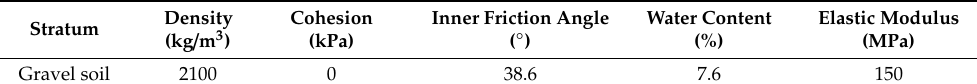
Table 6. Physical and mechanical properties of gravel soil.